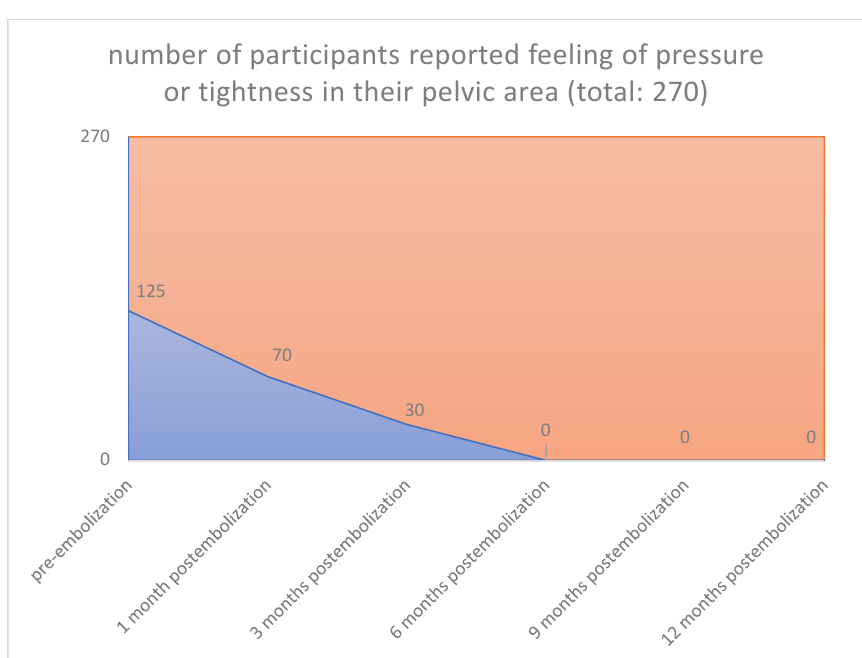
Figure 9. Pressure or tightness in pelvic area: Pre-embolization 125 from 270 participants reported feeling of pressure or tightness in their pelvic area. 1 Month 70 from 125 participants reported feeling of pressure or tightness in their pelvic area. 3 Months 30 from 125 felt pressure or tightness in their pelvic area. 6 Months 0 from 125 felt pressure or tightness in their pelvic area. 9 Months 0 from 125 felt pressure or tightness in their pelvic area. 12 Months 0 from 125 felt pressure or tightness in their pelvic area.